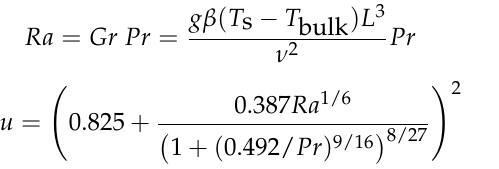
The horizontal surfaces on the top and bottom of the tank use two